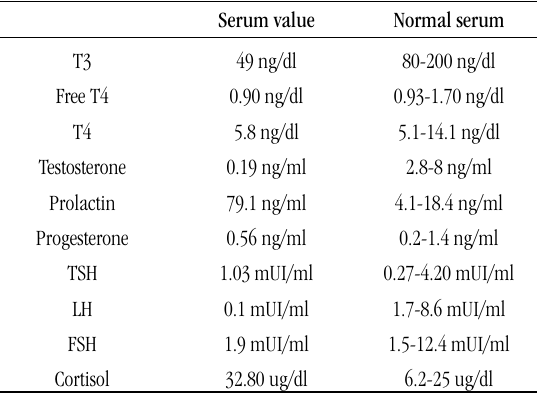
tABLE – Pilocytic astrocytoma: clinical data Serum value Normal serum